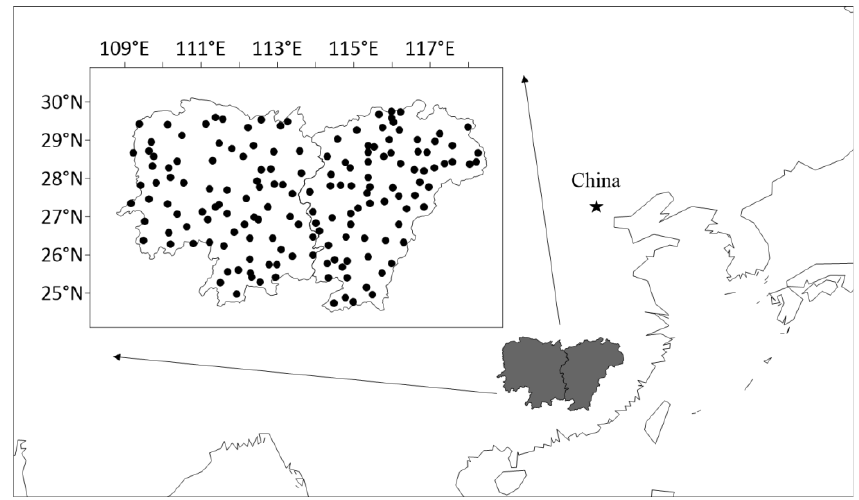
Figure 1. The map of study area and locations of stations.